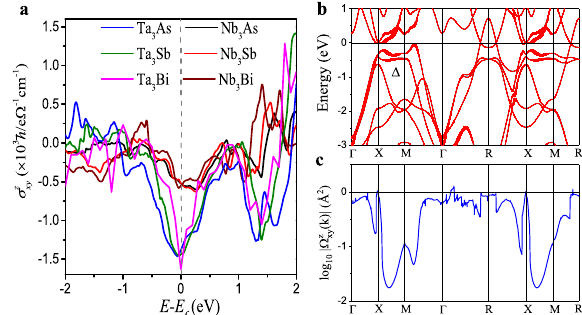
Fig. 4 The intrinsic spin Hall conductivity (SHC). a The SHC σ z function of the chemical position. The gray vertical line correspond- ing to the Fermi energy. Lines in different colors represent the SHC of different CNLSMs X 3 Y compounds. b The band-resolved SHC of Ta 3 As. c The momentum-resolved SHC of Ta 3 As along the high- symmetry momentum